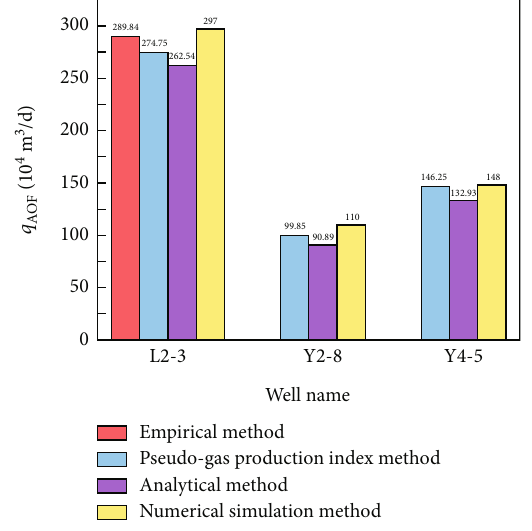
Figure 7: Comparison results of di ff erent calculation